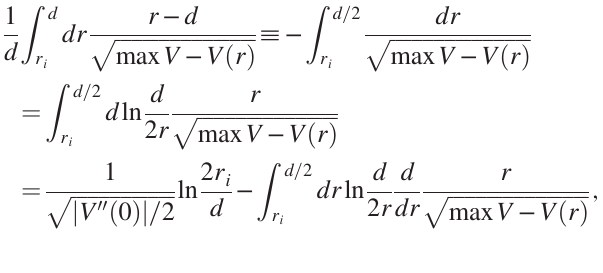
r − d ffiffiffiffiffiffiffiffiffiffiffiffiffiffiffiffiffiffiffiffiffiffiffiffiffiffi r ffiffiffiffiffiffiffiffiffiffiffiffiffiffiffiffiffiffiffiffiffiffiffiffiffiffi 1 ffiffiffiffiffiffiffiffiffiffiffiffiffiffiffiffiffiffiffi